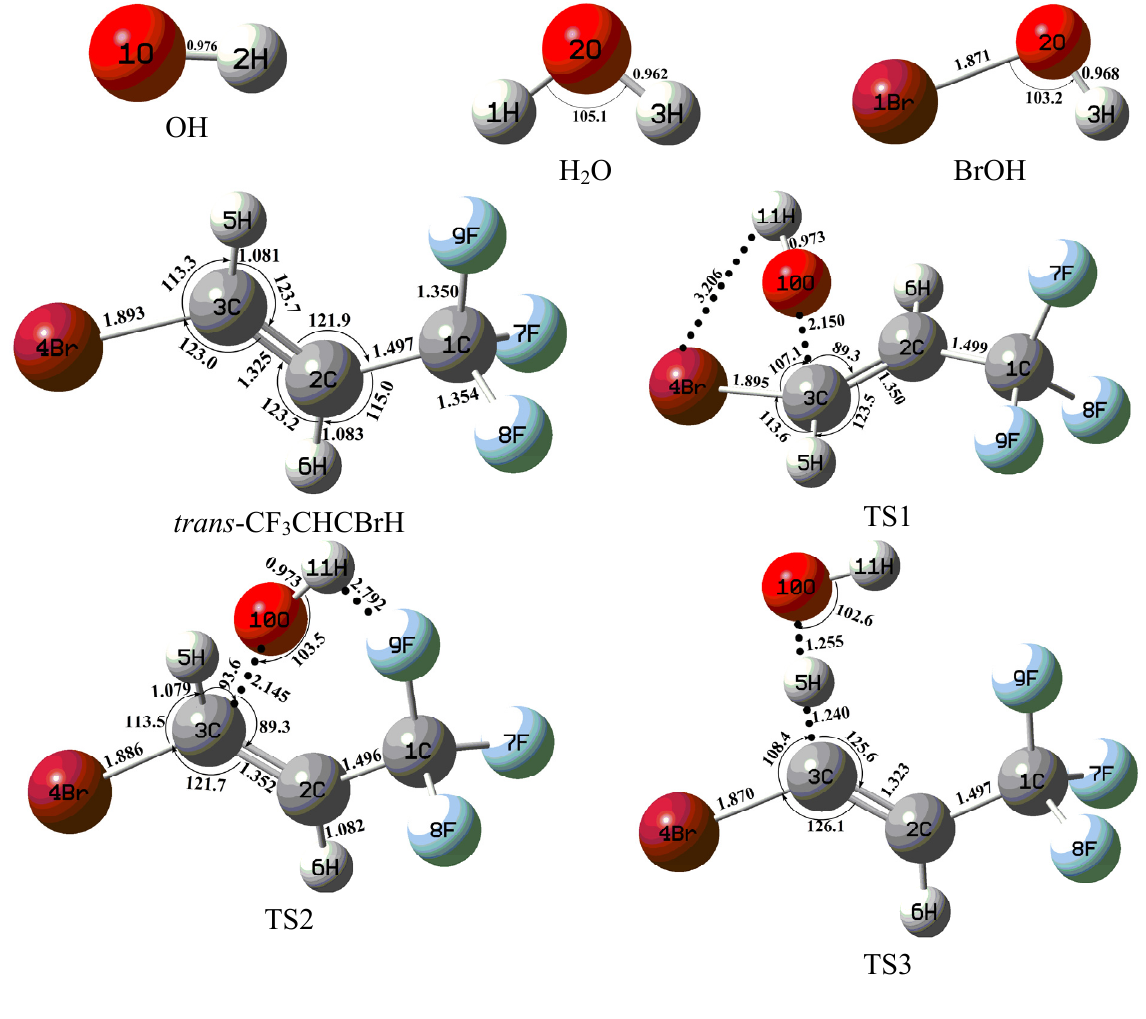
Figure 1. Optimized structures of various species involved in the reaction of trans- CF CHCBrH with OH free radical at the B3LYP/6-311++G(d,p) level. Bond distances are 3 in angstroms and angles are in